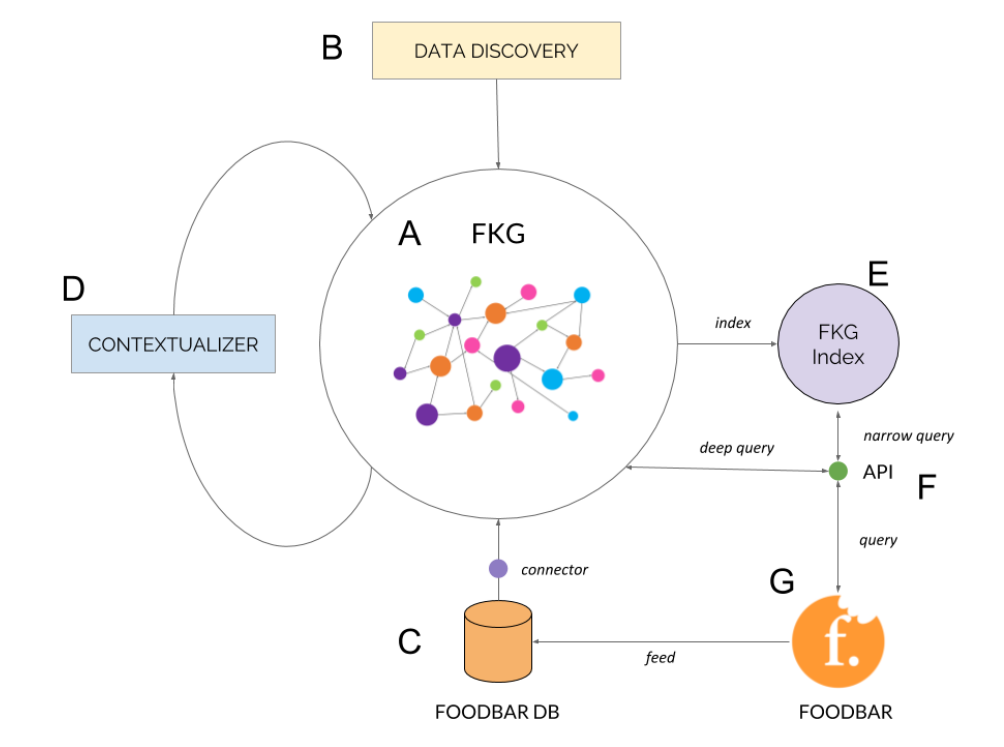
Figure 3. Architecture for foodbar knowledge